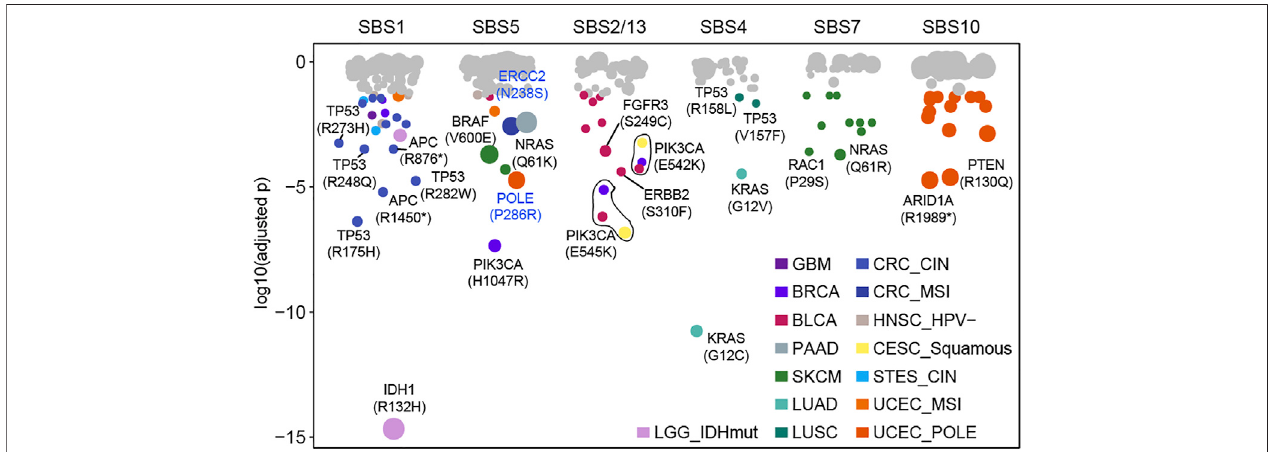
FIGURE 3 | Some mutations caused by a certain mutational process speci fi cally. Each dot represents a speci fi c relationship between mutation and mutational process. P values were obtained from the binomial test after multiple test corrections. Signi fi cant dots (adjusted p < 0.05) are fi lled by cancer type and the size of dots indicates the frequency of mutation in the corresponding cancer type or